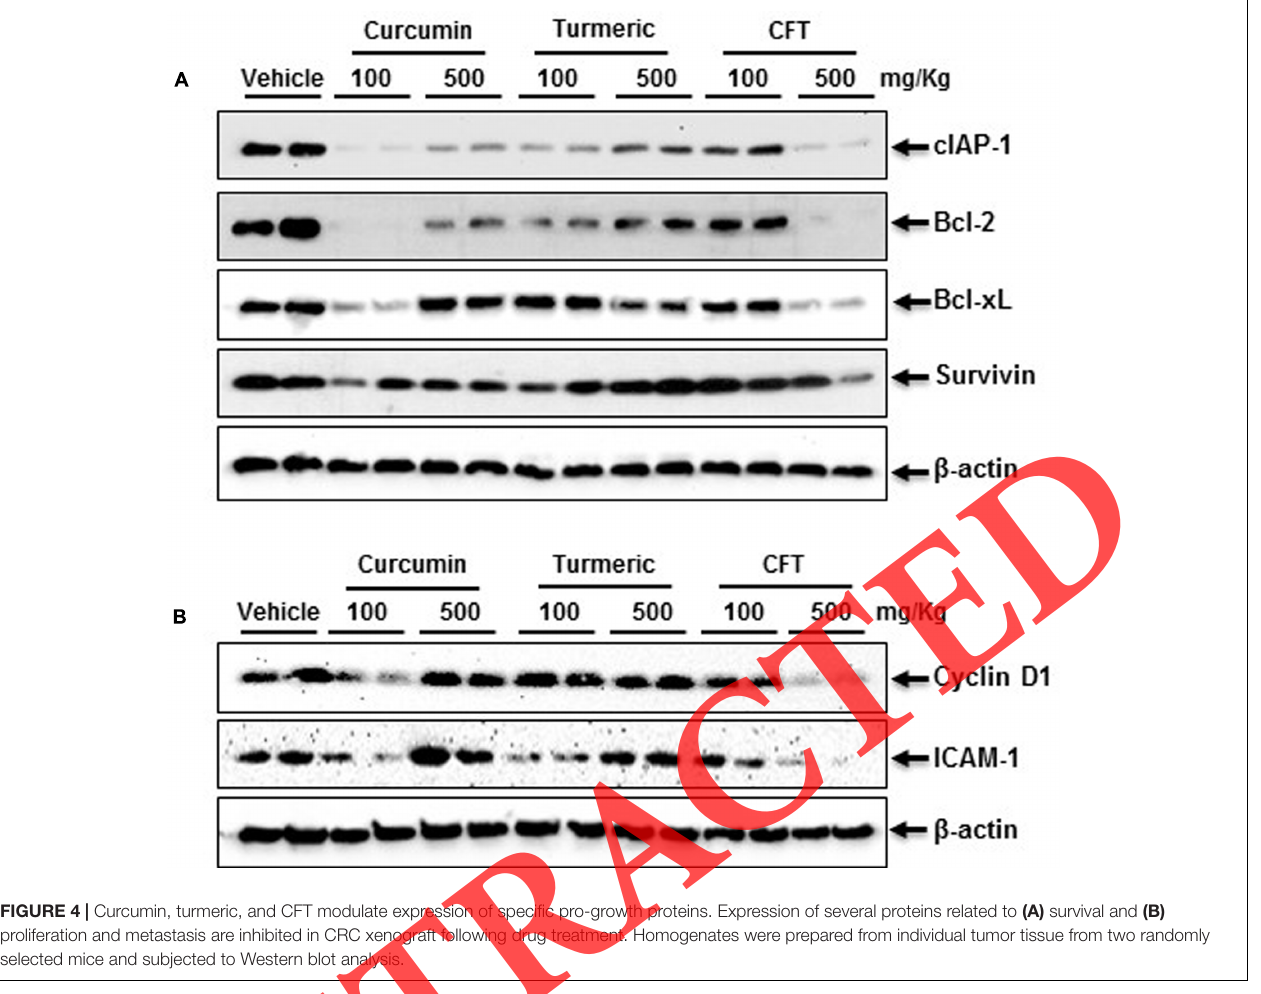
FIGURE 4 | Curcumin, turmeric, and CFT modulate expression of specific pro-growth proteins. Expression of several proteins related to (A) survival and (B) proliferation and metastasis are inhibited in CRC xenograft following drug treatment. Homogenates were prepared from individual tumor tissue from two randomly selected mice and subjected to Western blot